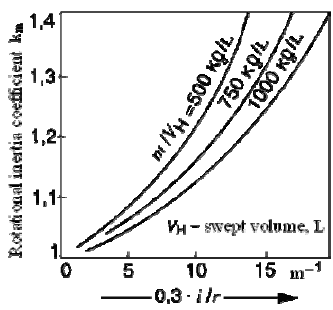
Fig 11. Definition of rotational inertia coefficient